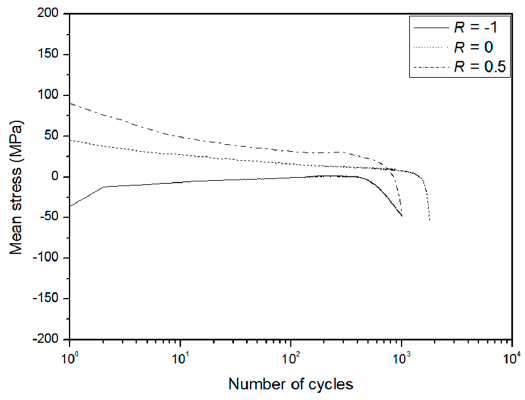
Figure 8. Mean stress versus number of cycles at strain amplitude 0.4%.